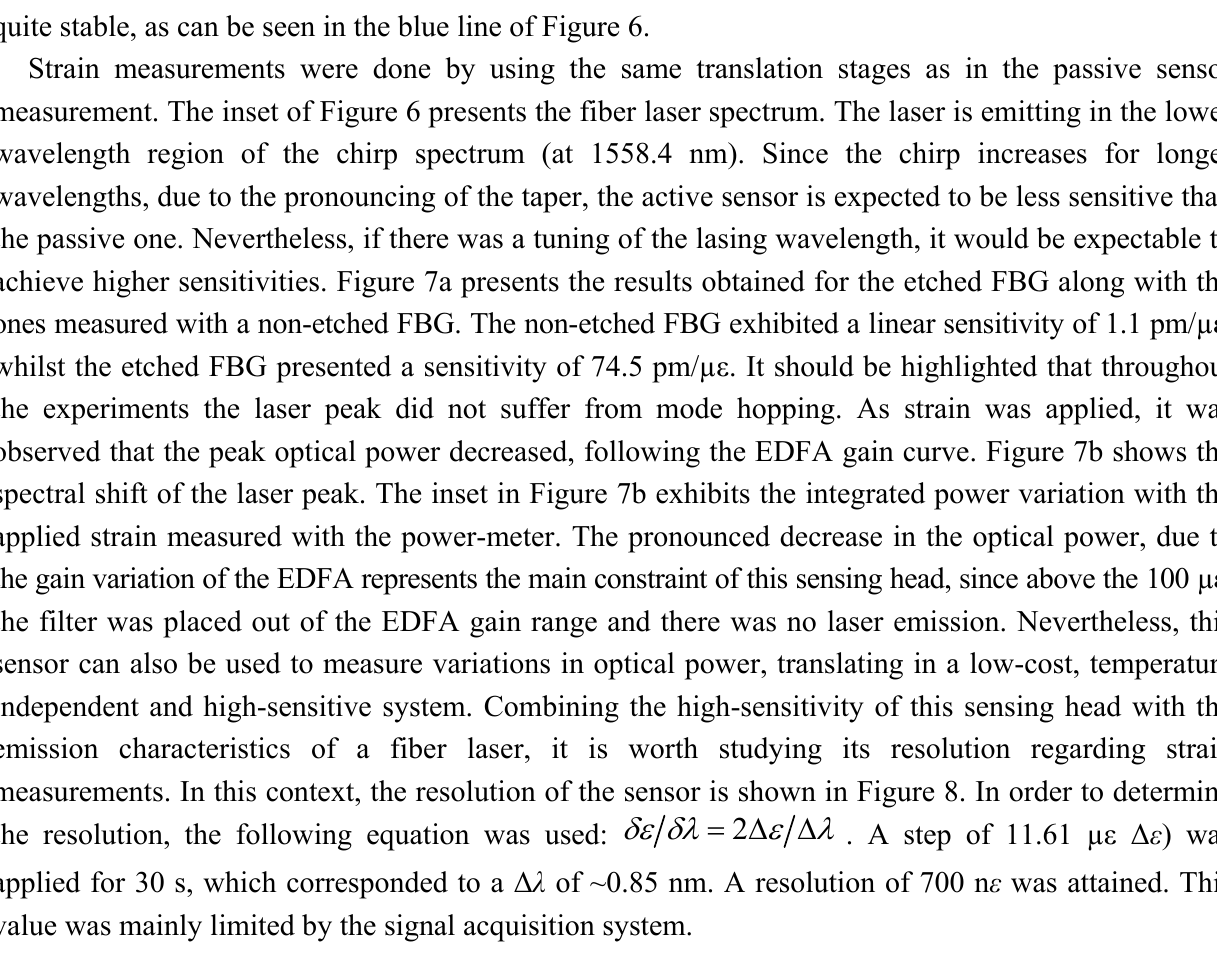
Figure 7. ( a ) Wavelength dependence on applied strain, for a non-etched FBG and an etched FBG; ( b ) Laser emission dependence on the applied strain. Inset: integrated power as a function of the applied